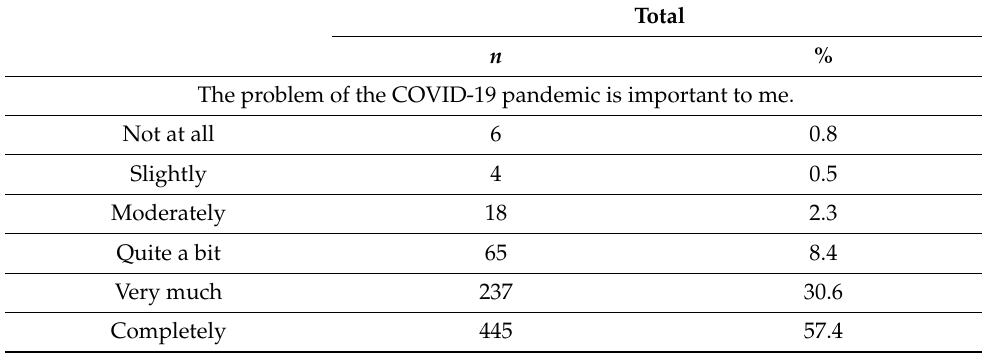
Table 5. Risk perception about